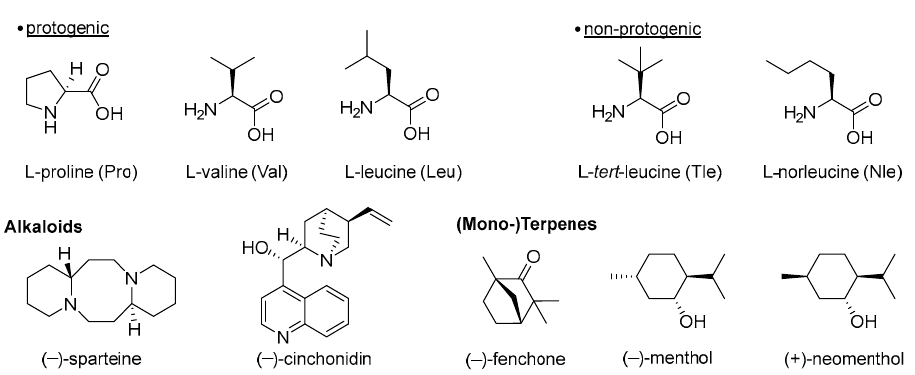
Figure 1. Examples of chiral pool motifs within the three important natural product classes for non-phosphine-based ligand systems.